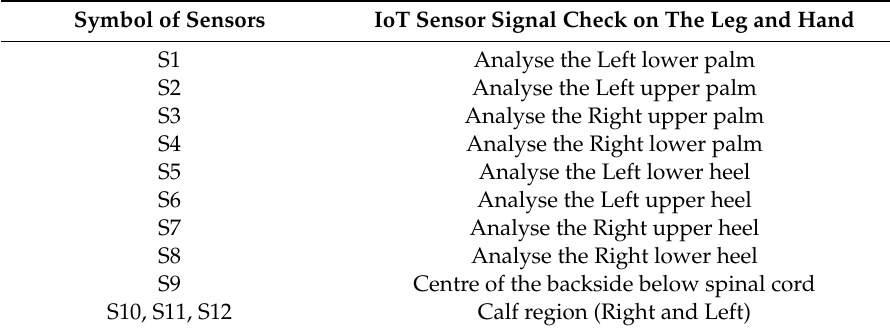
Table 3. Wearable smart log patch on the wrist—signal analysis.